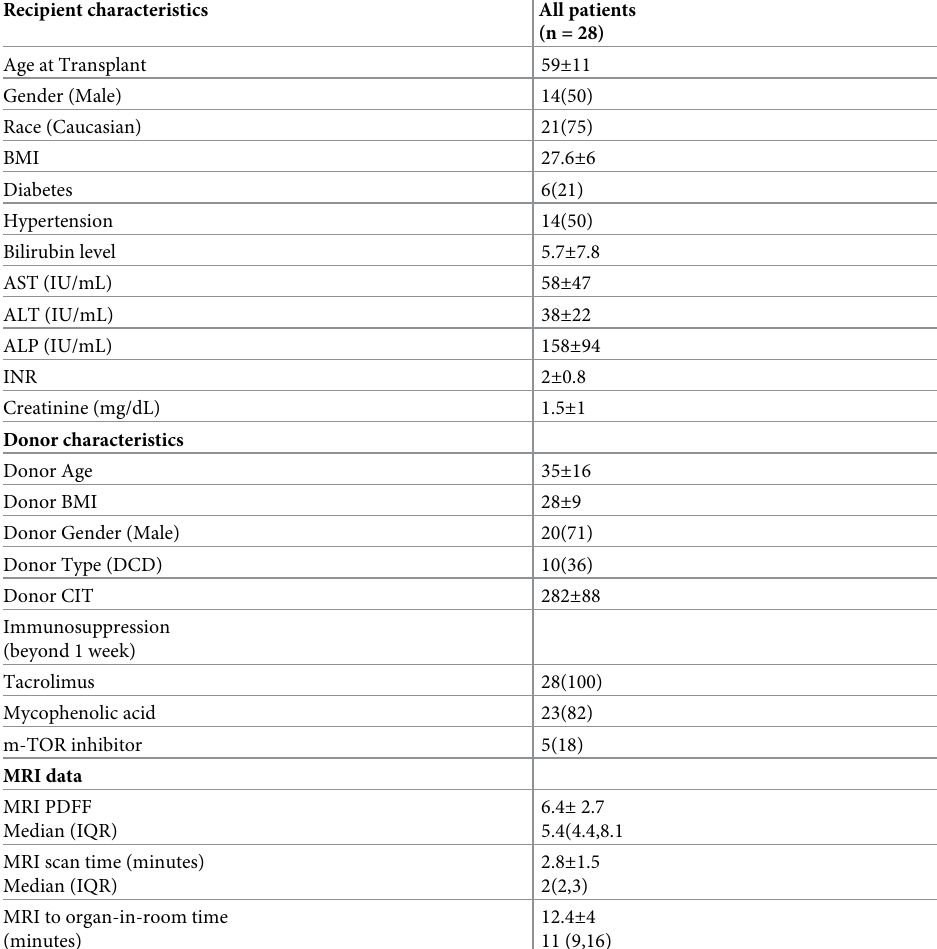
Table 1. Clinical and demographic characteristics of the donor and